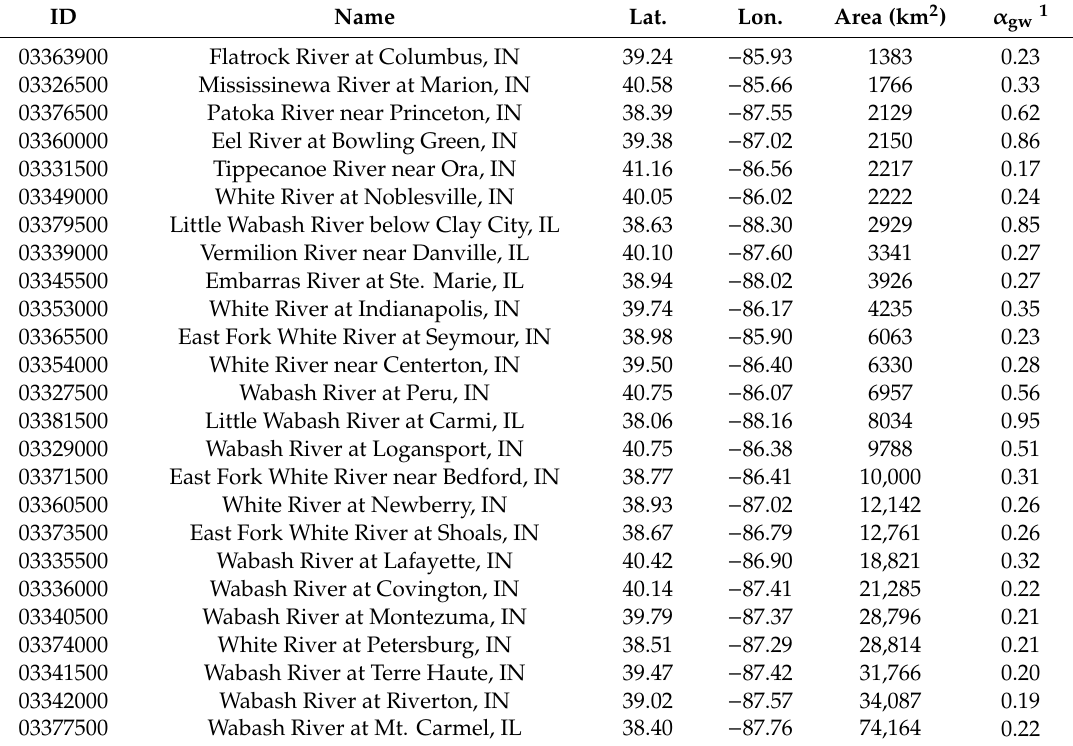
Table 2. USGS gauging stations used for model calibration.